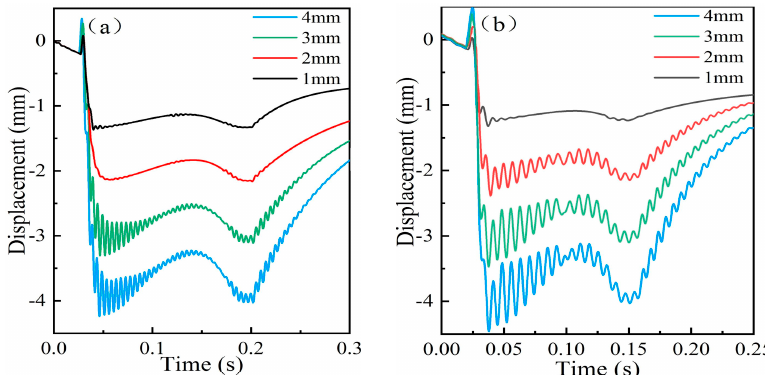
Figure 10. The motion state of the measuring ruler with different downward displacement: ( a ) The motion curves of the measuring ruler with different displacements at 30 km/h; ( b ) The motion curves of the measuring ruler with different displacements at 40 km/h.